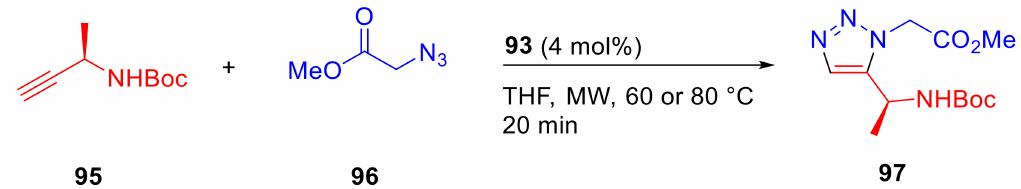
Scheme 30. Ru-catalyzed synthesis of 1,5-disubstitute 1,2,3-triazoles as bioisosteres of the amide